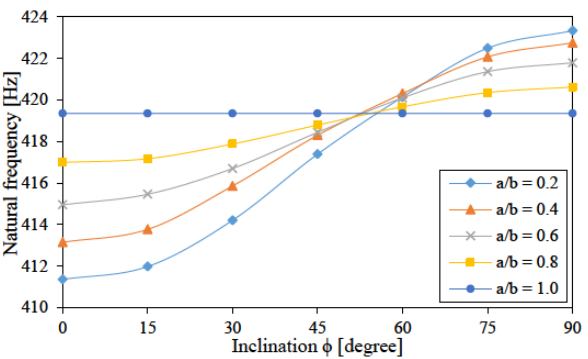
Figure 6: Effect of elliptical hole inclination on the variation of natural frequency (BC = CCCC; θ = [90/0/90/0]s)